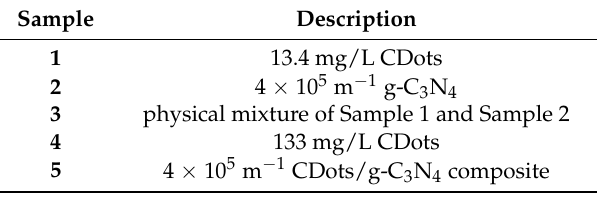
Table 1. Samples prepared for the investigation of synergistic effect of CDots and g-C 3 N 4 . Sample